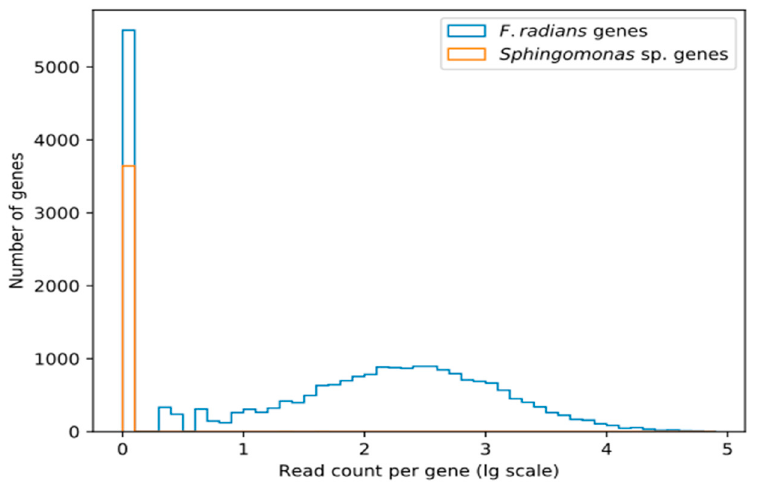
Figure 1. The number of transcriptomic reads mapping to putatively Sphingomonas ‐ derived and other (putatively F. radians ‐ derived) genes. Read counts are given in decimal log scale. Absence of these genes from transcriptomic data shows that they are not a part of F.